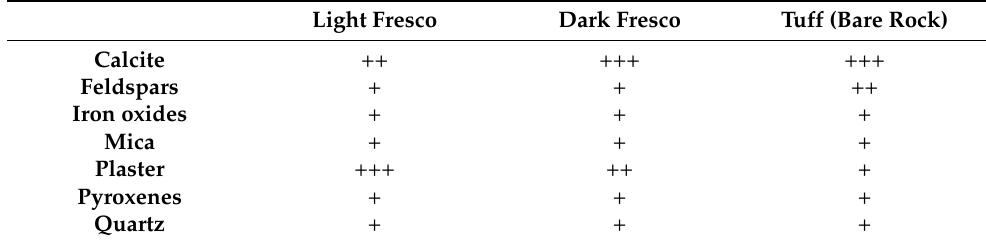
Table 2. Mineral composition of